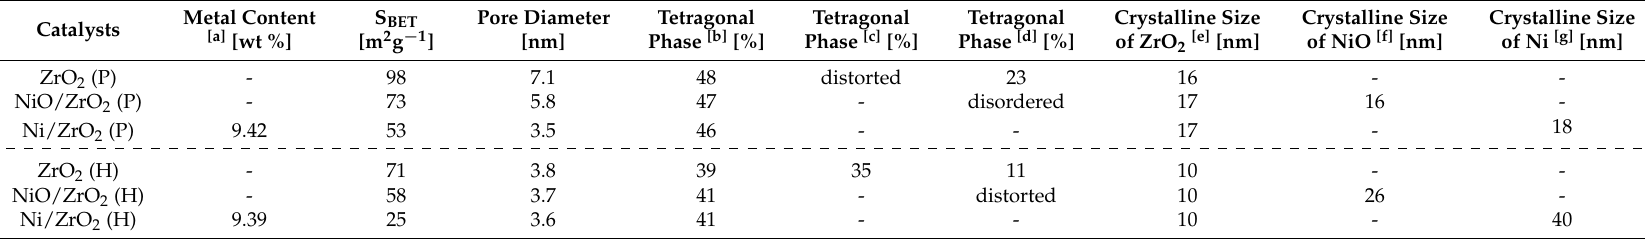
Table 1. A summary of metal content, specific surface area and pore diameter, calculated tetragonal phase content, and crystalline size of the ZrO 2 (P) and ZrO 2 (H) supports and their corresponding supported nickel